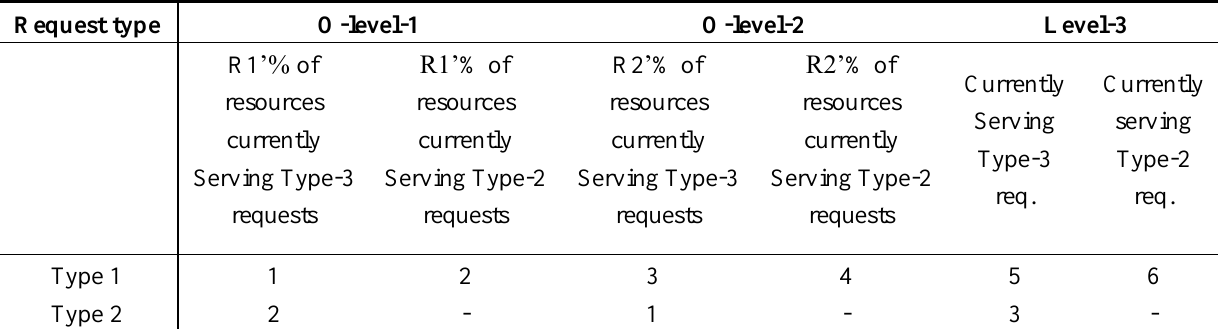
Table 8. The preemptive order of type-1 and type-2 requests. The lower the number, the higher the chosen